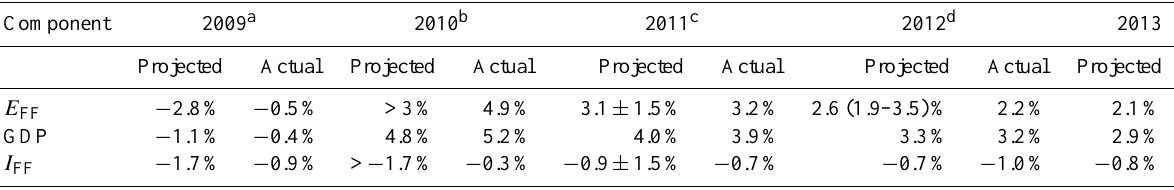
Table 9. Actual CO 2 emissions from fossil-fuel combustion and cement production ( E FF ) compared to projections made the previous year based on world GDP (IMF October 2013), and the fossil-fuel intensity of GDP ( I FF ) based on subtracting the CO 2 and GDP growth rates. The “Actual” values are the latest estimates available and the “Projected” values for 2013 refers to those presented in this